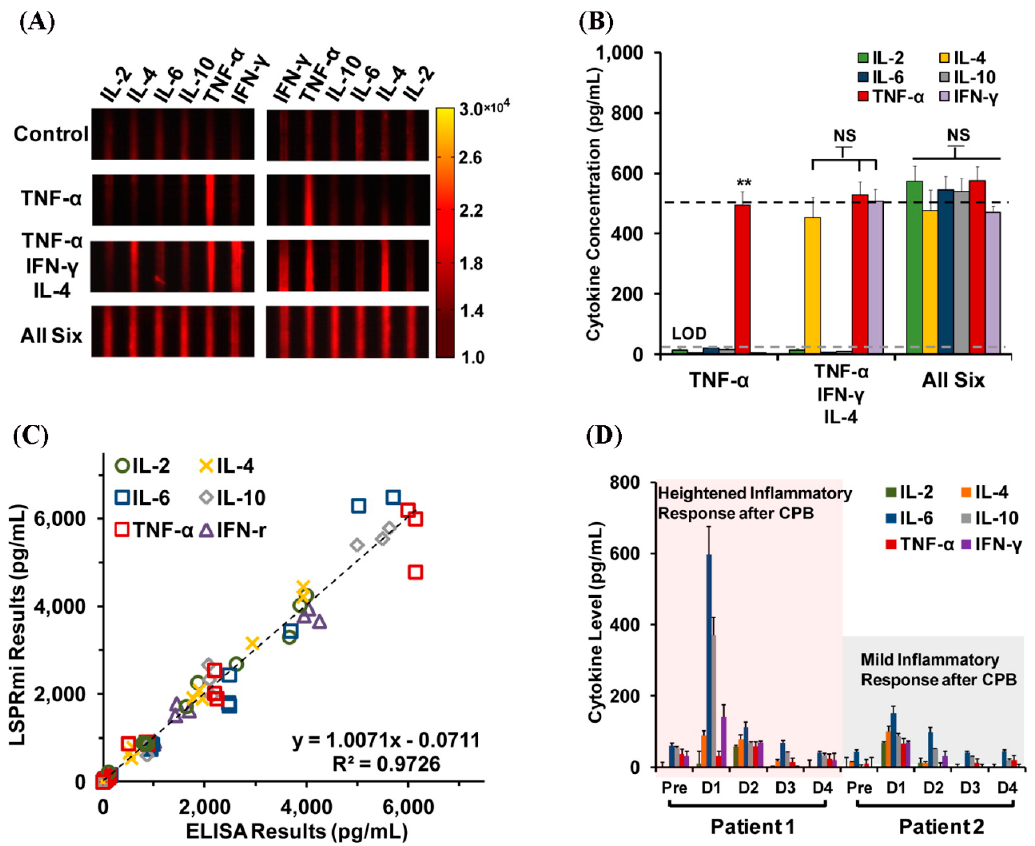
Figure 15. LSPR-based cytokine detection in healthy versus patient serum samples. ( A ) Dark-field images of AuNR microarrays within a single microfluidic detection channel loaded with different sample mixtures of recombinant cytokines (500 pg/mL for each cytokine) spiked in a serum matrix; ( B ) Cytokine concentrations are quantified for the samples in (A). The dashed black line represents the predetermined value of 500 pg/mL. The dashed grey line represents the DL of the LSPR microarray; ( C ) Correlations are made between the data obtained from the LSPR microarray assay and the gold standard ELISA for the spiked-in serum samples; ( D ) Five-day cytokine concentration variations were measured by the LSPR microarray assay for serum samples extracted from two post-cardiopulmonary bypass (CPB)-surgery pediatric patients. Reproduced with permission from Ref. [41] Copyright (2015) American Chemical Society.